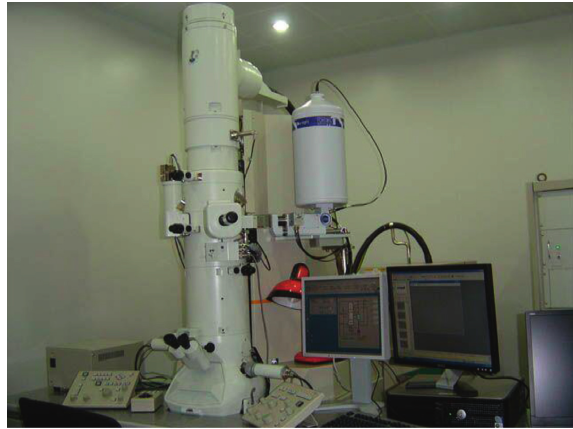
Figure 11: JEM-2100-type transmission electron